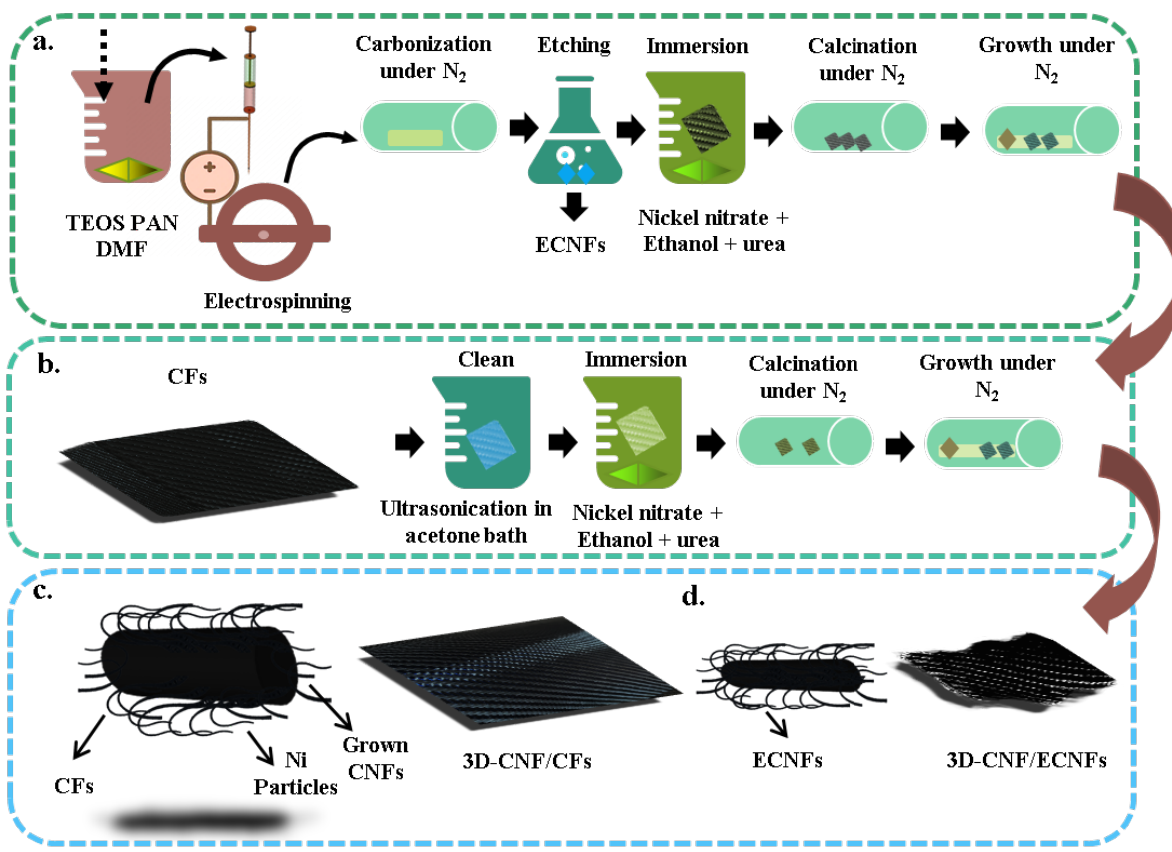
Figure 3. The steps resulting in the production of: ( a ) ECNFs and 3D-Ni/CNFs/ECNFs, ( b ) 3D- Ni/CNFs/CFs, ( c ) 3D-Ni/CNFs/CFs, and ( d ) 3D-Ni/CNFs/ECNFs. Adapted with permission from Ref. [55]. Copyright © 2021, Elsevier.